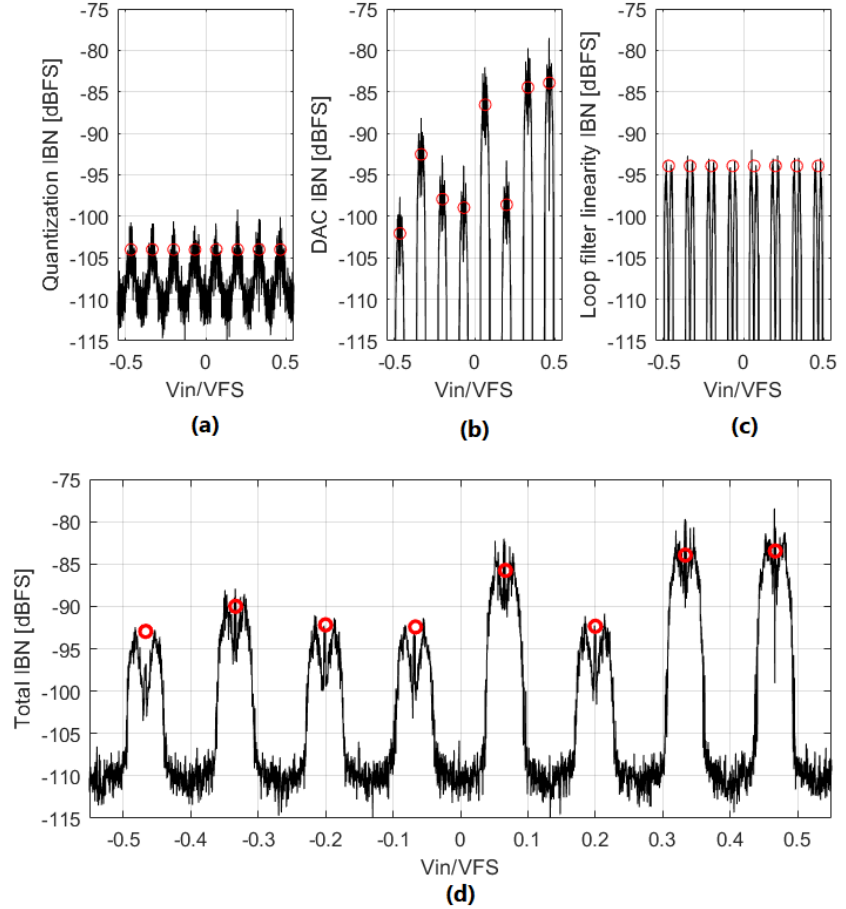
Figure 21. Comparison of the contributions of the different IBN sources analyzed in this article. The black lines represent the simulated IBN power; the red circles mark the estimated IBN power in NP regions. Input signal is a very slow ramp. Σ∆ M parameters are: third-order, 4-bits, OBG = 1.7, OSR = 48, g 3 = 0.25. Output signal is divided in segments of 2.13 ms. ( a ) Quantization IBN power. ( b ) DAC mismatch IBN power. ( c ) Loop filter linearity error IBN power. ( d ) Total IBN